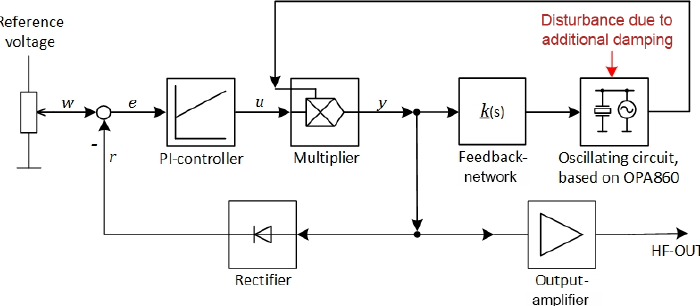
Figure 6. Block diagram of the new compact and low-cost circuit.